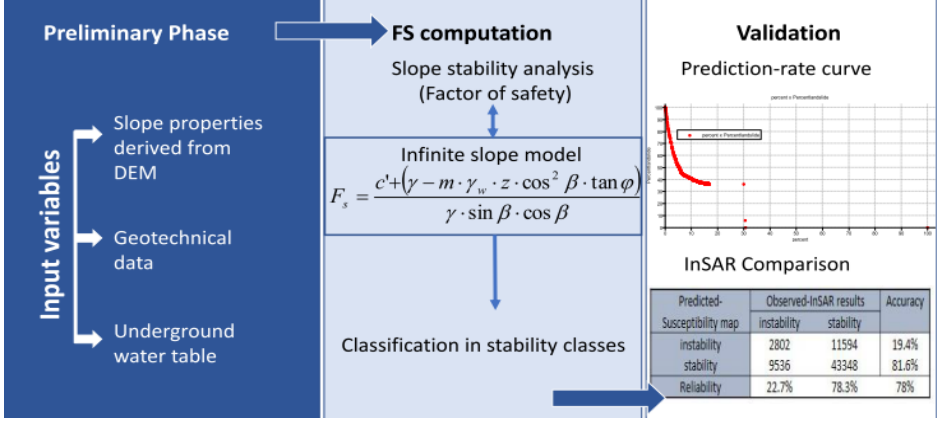
Figure 4. General workflow.